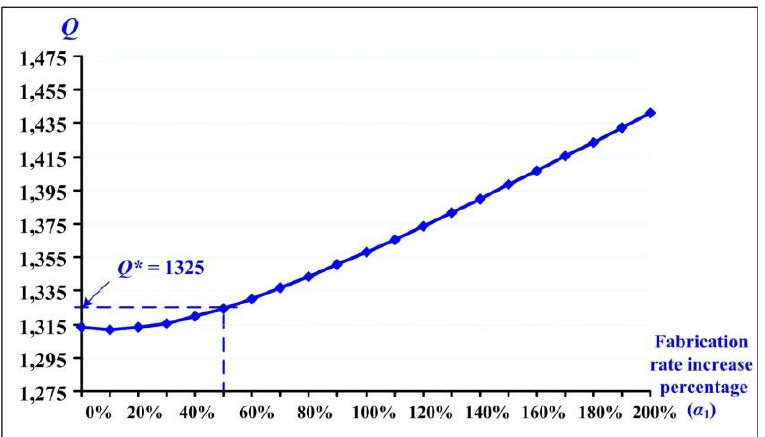
Figure 8. Differences in fabrication rate increase percentage effects on manufacturing